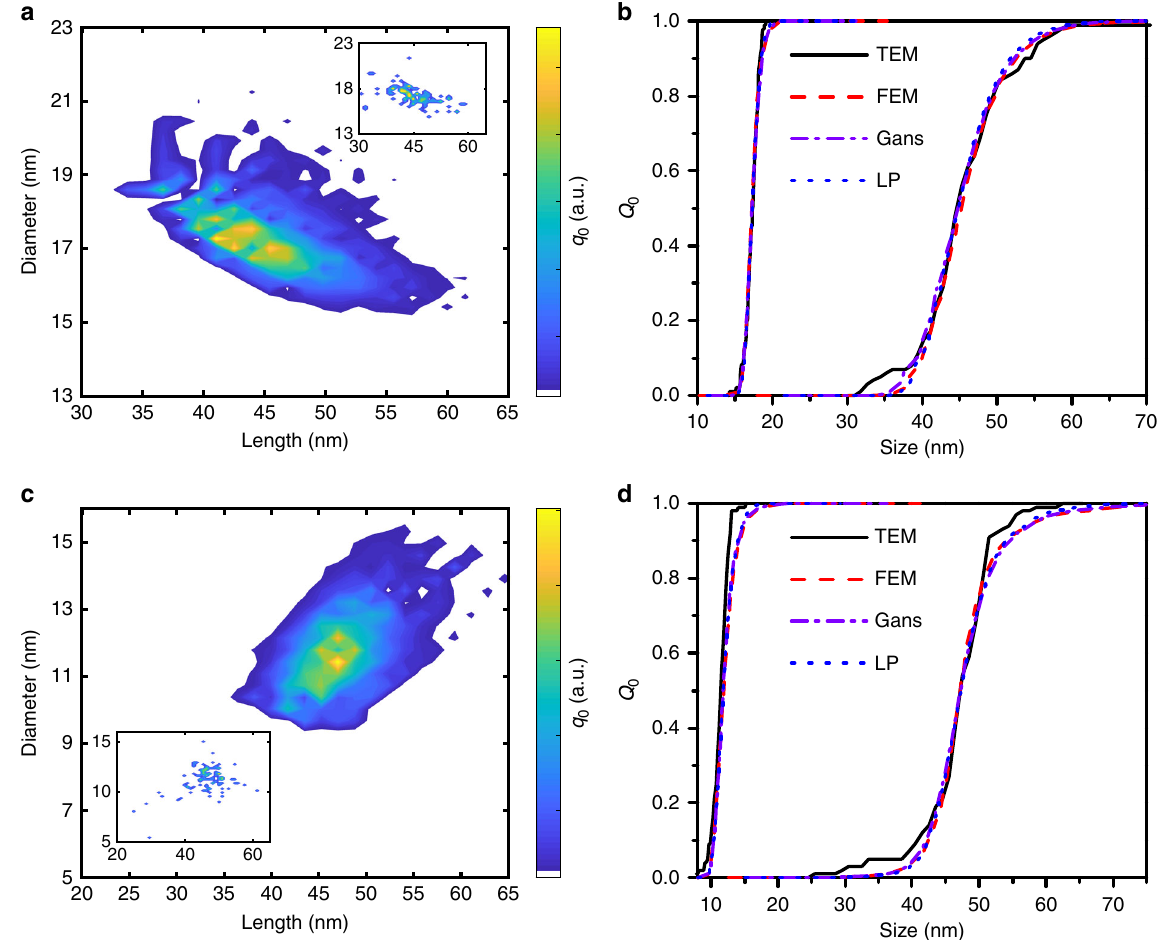
Fig. 7 Resulting size distributions for the fi rst and second citrate sample. Comparison of a 2D length and diameter distribution (Gans), b the corresponding two one-dimensional size distributions for citrate sample 1 for the different optical models and c the two-dimensional size distribution (Gans), d the corresponding two one-dimensional size distributions for citrate sample 2 in comparison with results from TEM analysis. The insets show the size distribution of nanorods obtained by TEM. One hundred particles were TEM-counted for each sample